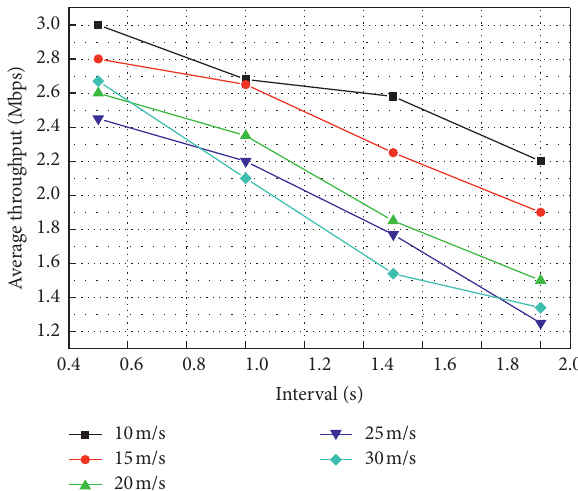
Figure 5: Average network throughput with speed for different hello